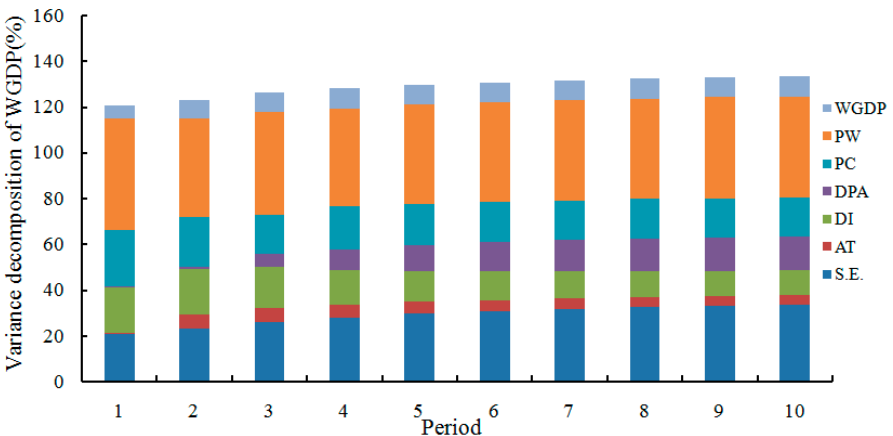
Figure 6. Variance decomposition of WGDP.